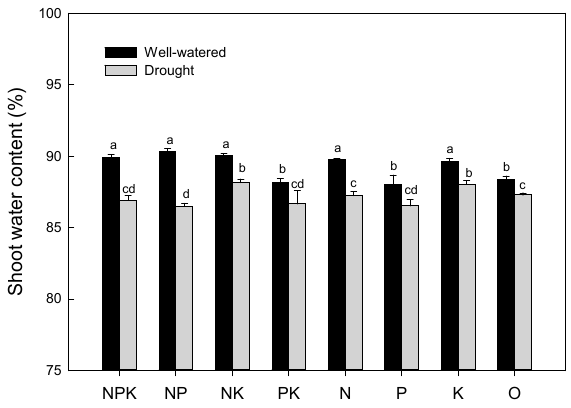
Figure 5. Interactive effects of drought and the N, P and K nutrients applied individually or in combination, or with no nutrient application (0) on the shoot water content of the maize seedlings at day 20 after sowing. The error bars represent the standard errors of the mean ( n = 3) and fit within the plot symbol if not visible. Means accompanied by different letters are significantly different at p <